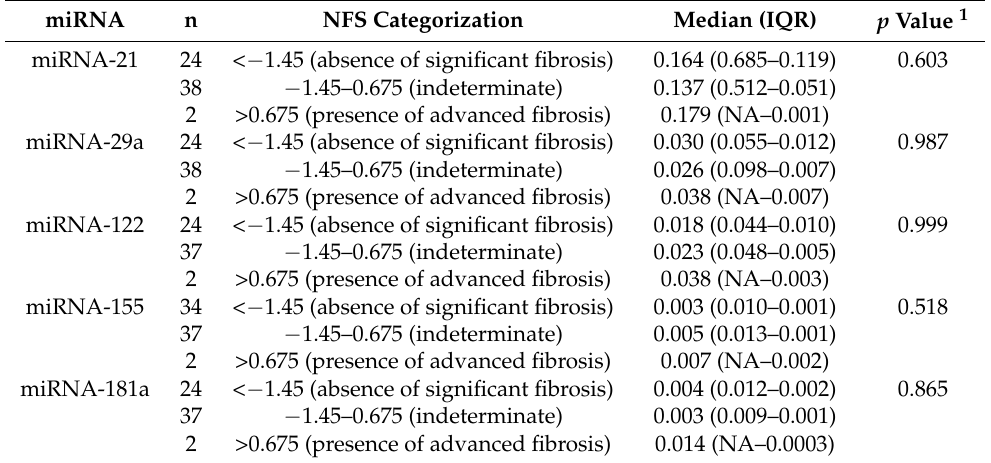
Table 4. Comparison between microRNAs and the categorization of the NAFLD fibrosis score